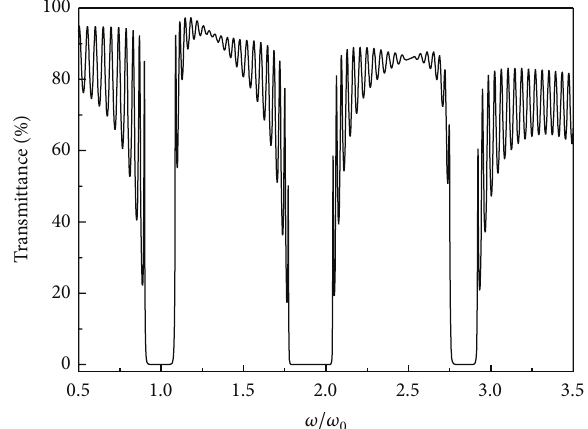
Figure 1: Transmission spectrum of one-dimensional photonic crystal at 0 ∘ incidence.